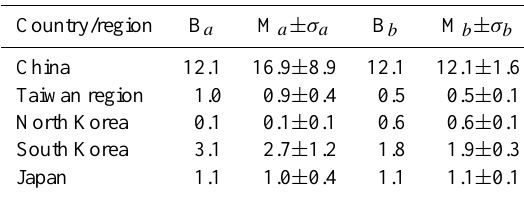
Table 5. HCFC-141b emissions (kt/yr) per country/region for the year